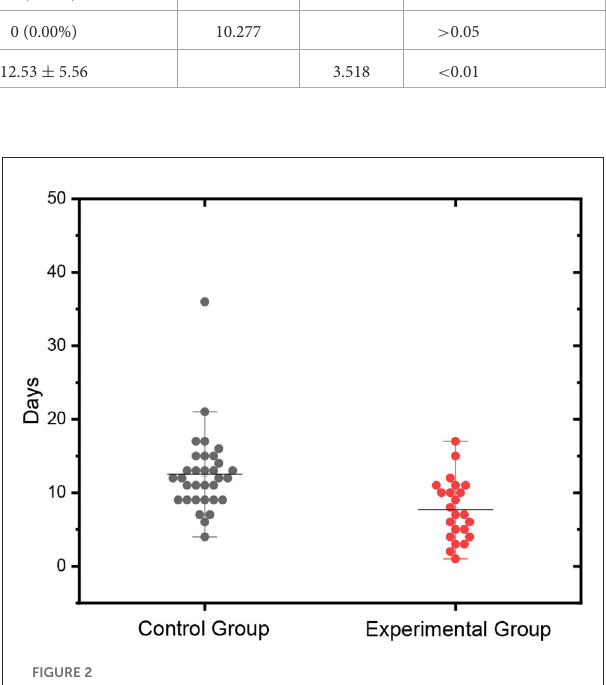
FIGURE2 Scatter plots of hospitalization